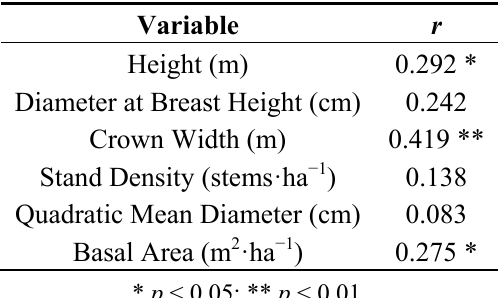
Table 2. Pearson correlation coefficients between mean stem-level area weighted fibre length and continuous predictor variables entered into the regression tree